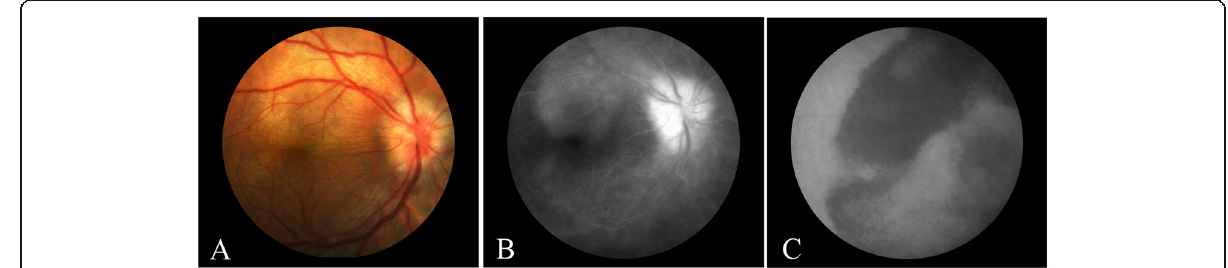
Fig. 4 Fundus color picture showing a typical large, roundish, yellowish, placoid lesion affecting the RPE within the macular are, hallmark of ASPP C ( A ). At fundus fluorescein angiography, the macular lesion corresponds to an hyper-fluorescent area ( B ), while indocyanine green angiography presents an obvious hypo-fluorescence matching the FFA findings ( C )